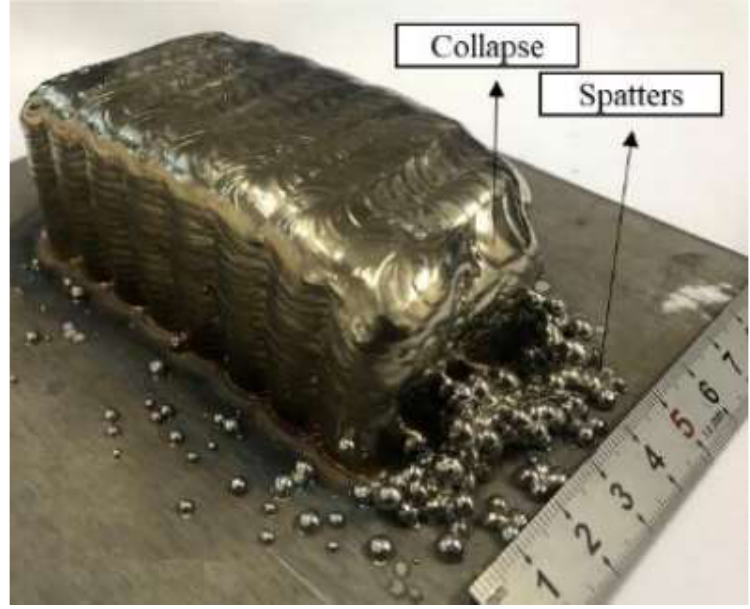
Figure 6. Spa(cid:308)er and collapse defects in WAAM, adapted from [18]. Figure 6. Spatter and collapse defects in WAAM, adapted from